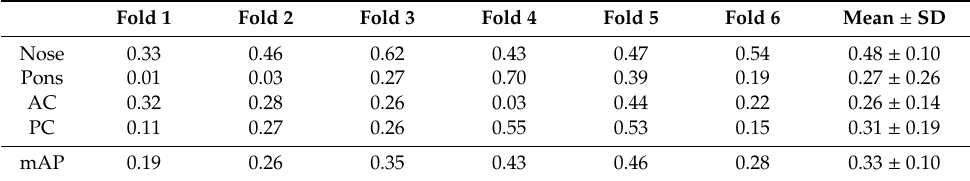
Table 2. AP and mAP for the ROIs measuring 32 × 32